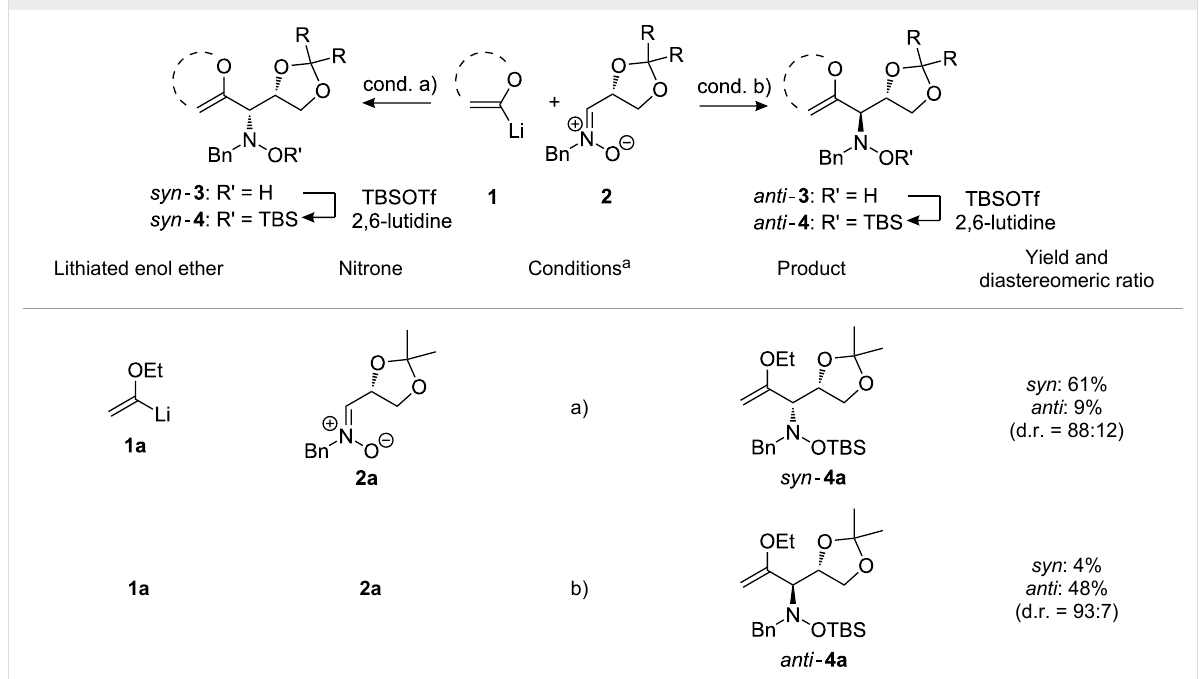
Table 1: Stereodivergent additions of lithiated enol ethers 1 to glyceraldehyde-derived nitrones 2 .